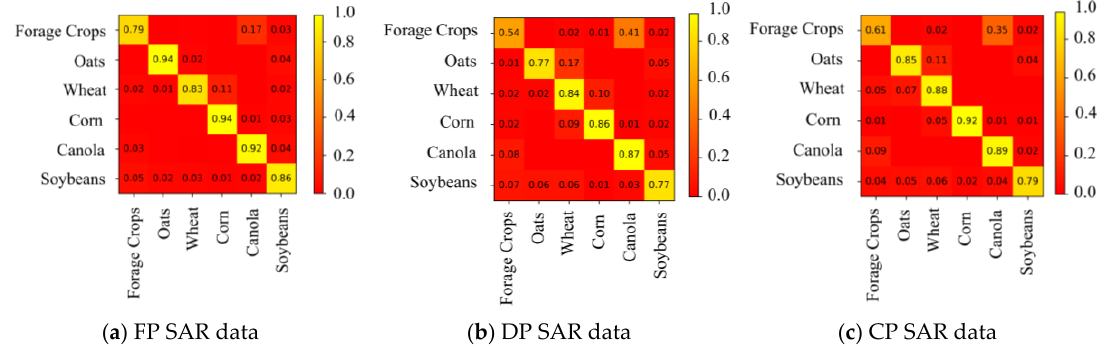
Figure 11. The final land cover maps obtained from the uncorrelated CP SAR features using ( a ) pixel-based and ( b ) object-based RF classifications.